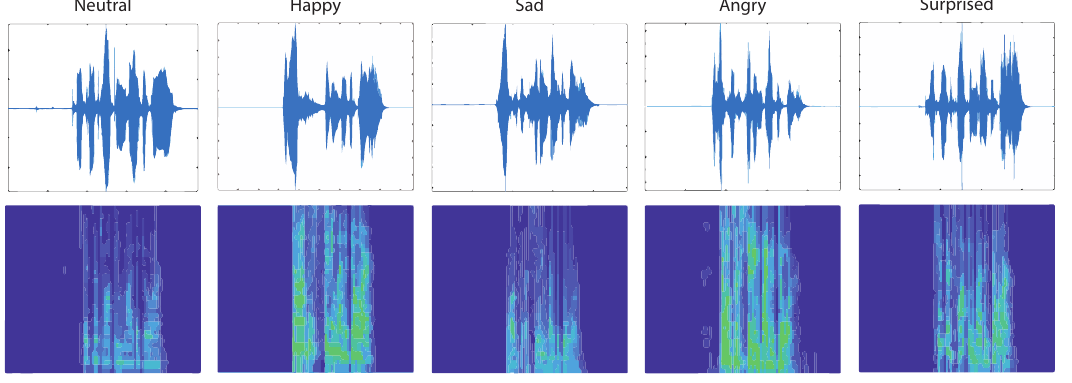
Figure 5. Audio waveforms and their spectrograms for the five basic